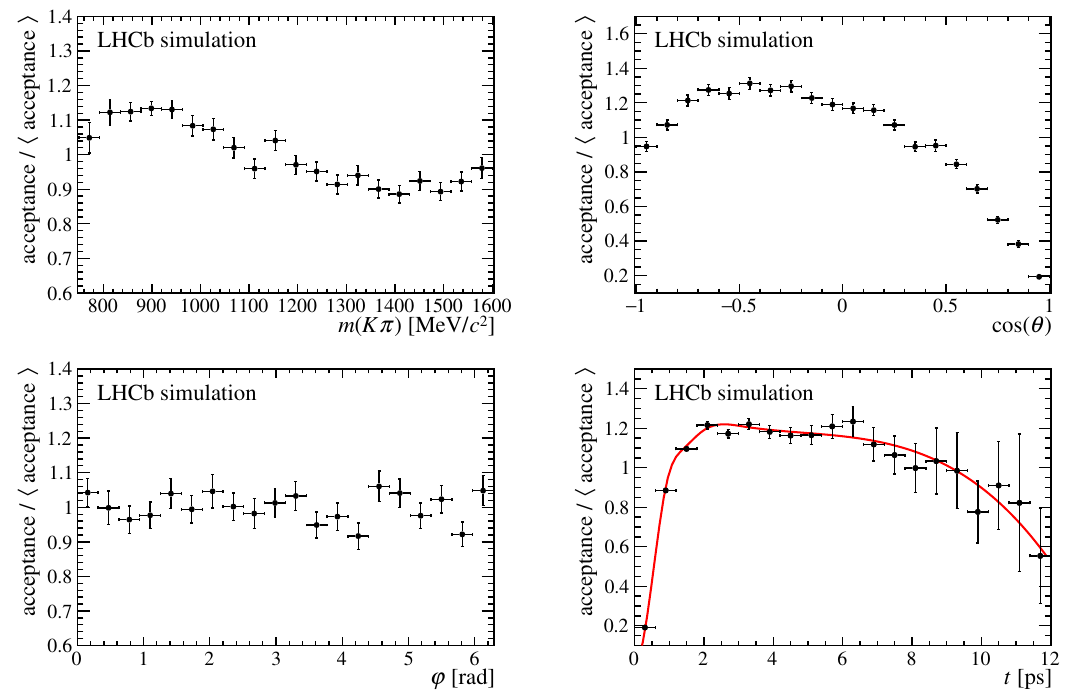
Figure 5 . Kinematic acceptance and decay-time distributions evaluated with simulated vector- vector B 0 K (cid:3) 0 K (cid:3) 0 and pure phase-space B 0 ( K + (cid:25) (cid:0) )( K (cid:0) (cid:25) + ) candidates scaled by the mean s ! s ! acceptance. In the bottom right plot the decay-time acceptance obtained from the simulated sample is shown as the black points and the parametric form of the acceptance obtained with cubic splines is shown as the red curve. In the other three plots the black points show the acceptance distribution for the masses and angles. The two cos (cid:18) variables and the two m ( K(cid:25) ) masses have been averaged for the purpose of illustration. In the (cid:12)t, the kinematic acceptance enters via the normalisation weights.